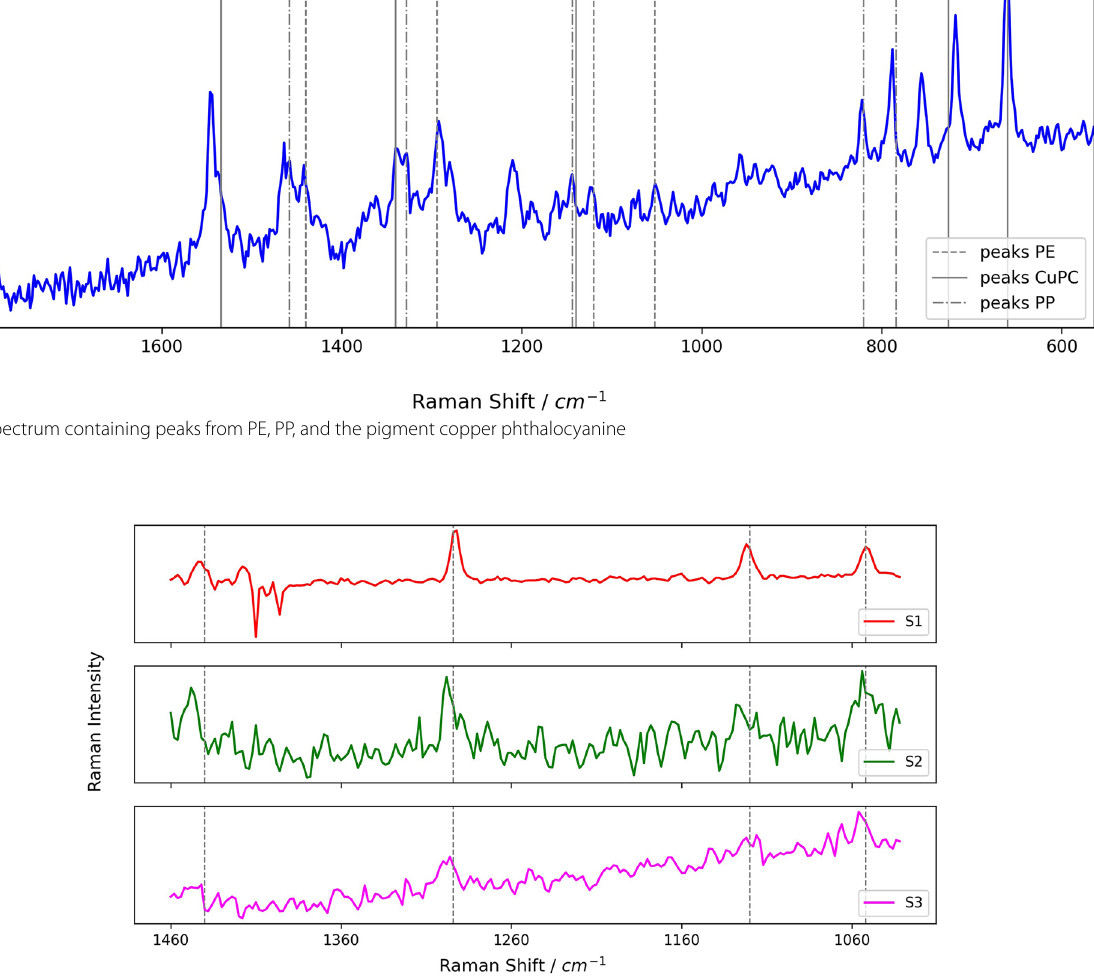
Fig. 8 PE spectra from different microplastic particles: The quality (signal to noise-ratio, peak position, interference) of the spectra varies